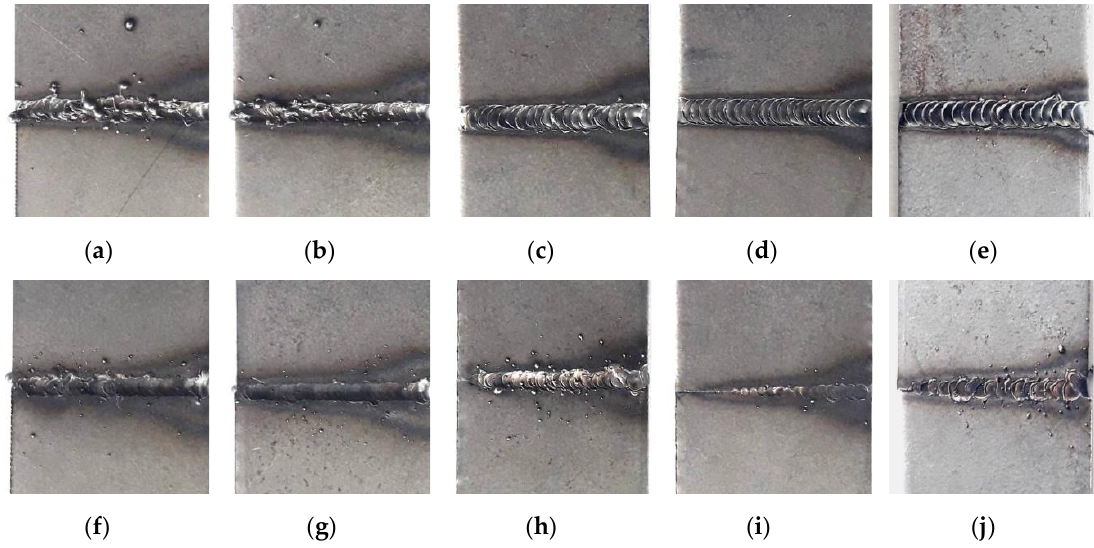
Figure 5. The weld bead aspect before the tensile testing: weld face for ( a ) Sample 1, ( b ) Sample 2, ( c ) Sample 3, ( d ) Sample 4, ( e ) Sample 5, and root face for ( f ) Sample 1, ( g ) Sample 2, ( h ) Sample 3, ( i ) Sample 4, ( j ) Sample